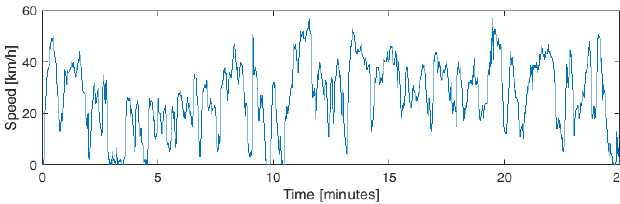
Figure 10. Urban speed profile.